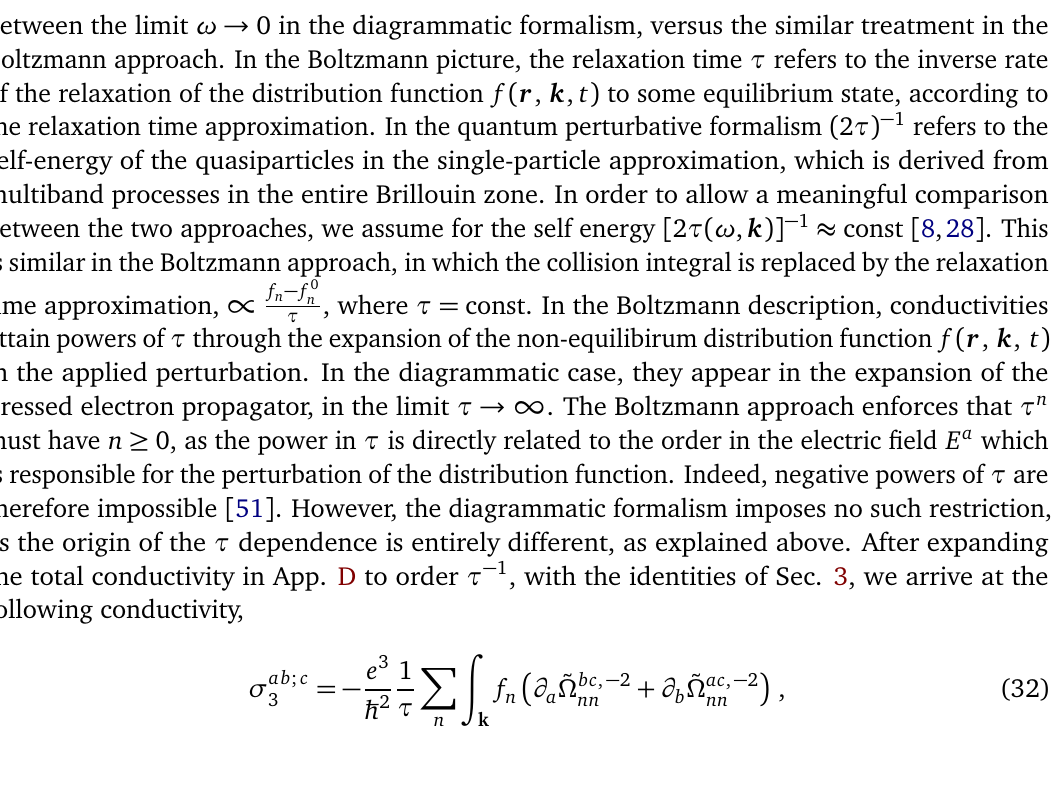
Figure 4: 2nd harmonic nonlinear conductivity in the vicinity of ¯ ω = E denote resonant contributions, while empty circles are off-resonant terms. We find that in the vicinity of this resonance, injection, and counter-injection conductivities cancel each other, below the gap. Throughout, α = 2, and the chemical potential µ = 0, making the Fermi surface contribution identically